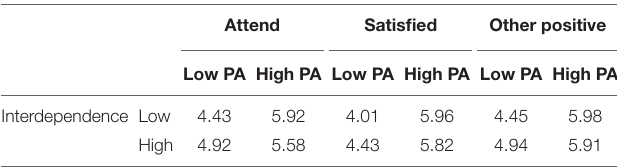
TABLE 4 | Predicted values in social interaction outcomes for a combination of low and high Positive affect and Interdependent self-construal. Attend Satisfied Other positive